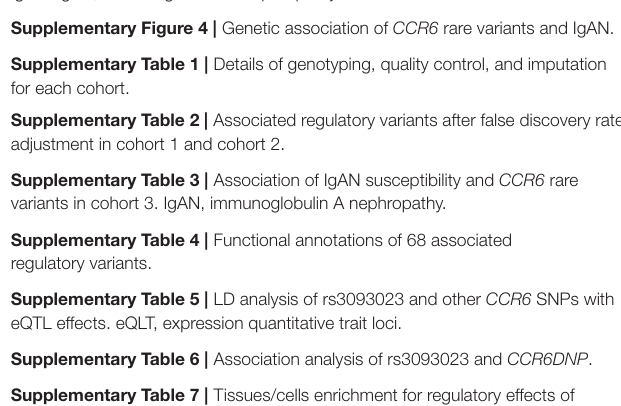
Supplementary Table 6 | Association analysis of rs3093023 and CCR6DNP